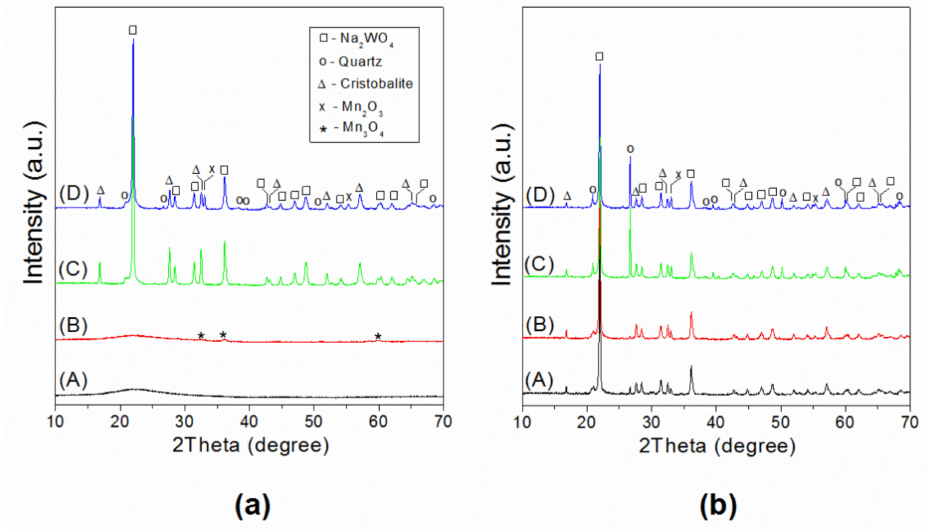
Figure 1. XRD patterns of ( a ) fresh ( A ) SiO 2 , ( B ) Mn/SiO 2 , ( C ) Na 2 WO 4 /SiO 2 and ( D ) Mn- Na 2 WO 4 /SiO 2 samples and ( b ) Mn-Na 2 WO 4 /SiO 2 samples after OCM process using mixture of ( A ) biogas1 + O 2 + He and ( B ) biogas2 + O 2 + He ( C ) CH 4 + O 2 + He, ( D ) CH 4 + O 2 + CO 2 + He. Reaction conditions: T = 1053 K; GHSV = 11,550 cm 3 · g − 1 cat · h − 1 ; m cat = 400 mg; total flow rate =